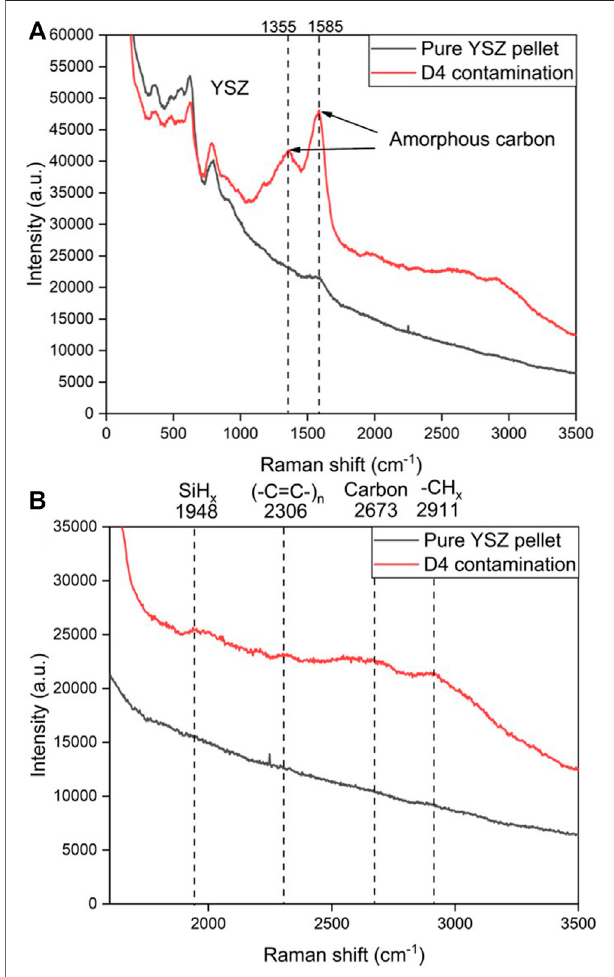
FIGURE 9 | Postmortem Raman spectra acquired from the YSZ pellet after 120 h D4 contamination at 750 ° C vs. pure YSZ pellet spectra. (A) Entire Raman spectra; (B) Raman spectra ranges from 2000 to 3,500 cm − 1